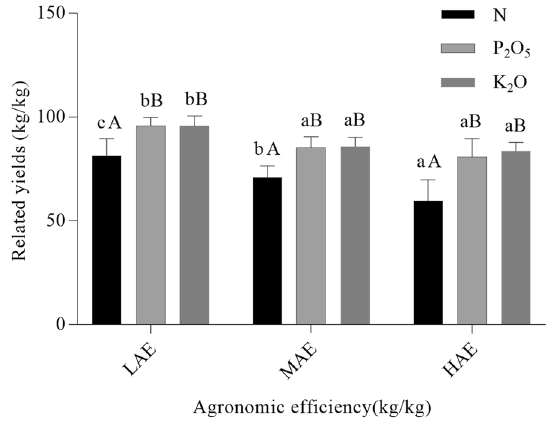
Figure 2. The relative yield (mean ± SD) of N, P 2 O 5 and K 2 O fertilizer applications at low (LAE), medium (MAE), and high agronomic efficiency (HAE). Within each level, different capital letters indicate a significant difference at P < 0.01, whereas among the agronomic efficiency (AE) levels different lower-case letters indicate a significant difference at P < 0.05.